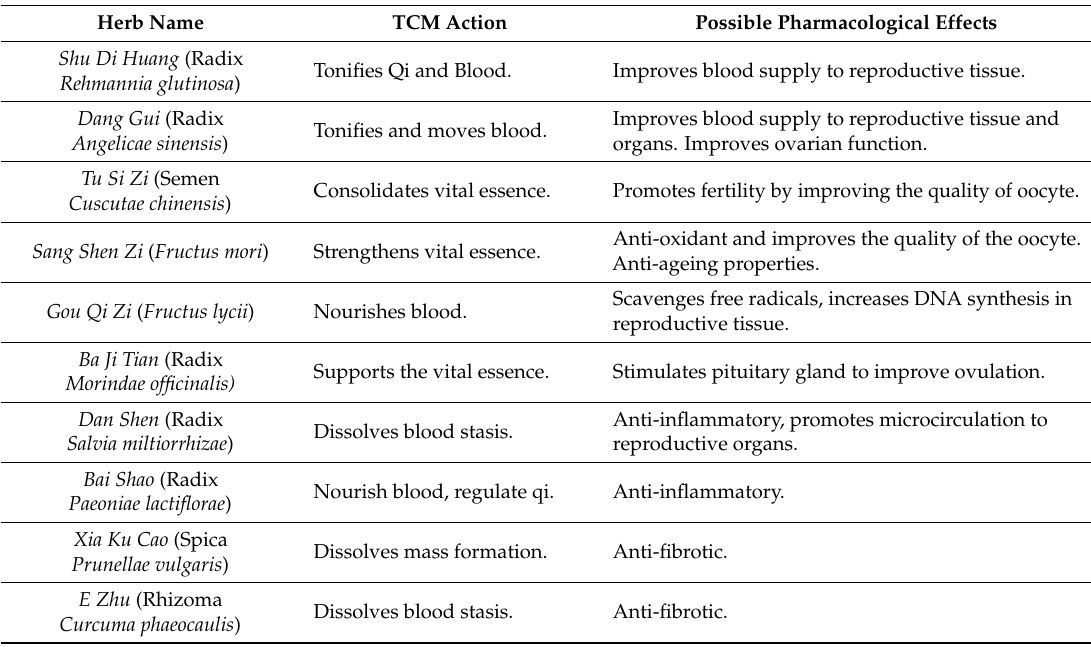
Table 1. Description of Chinese Herbal Formula and Possible Pharmacological Effects